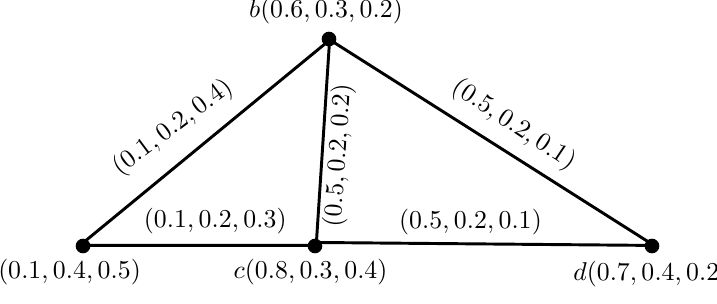
Figure 1. Intuitionistic neutrosophic graph